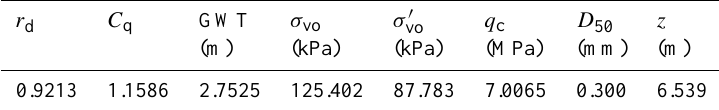
Table 5. The reference soil characteristics in parametric